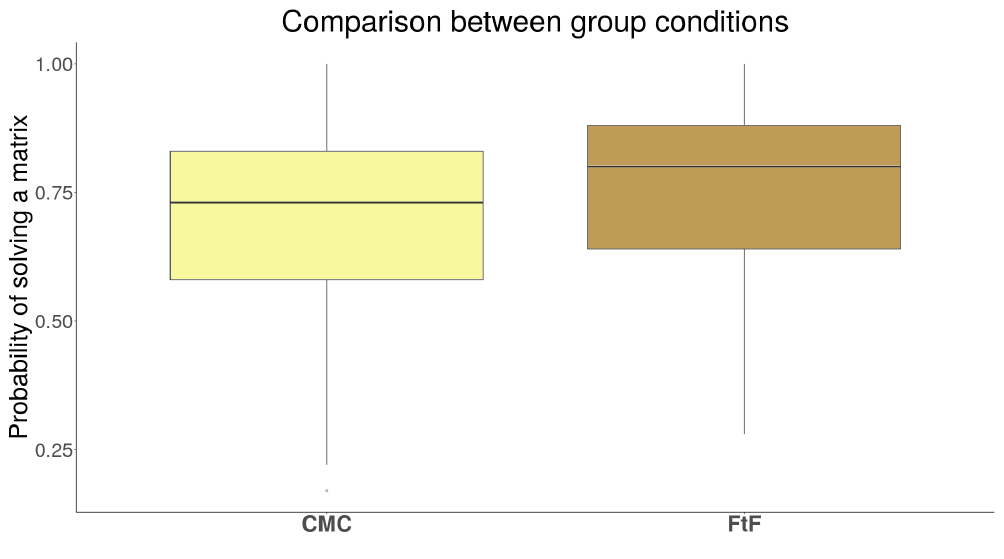
Figure 6. Comparison between performance of groups in CMC and FtF conditions. A box-plot is shown, comparing the performance in RAPM of the groups involved in computer-mediated-communication (CMC) and groups involved in face-to-face condition (FtF). The horizontal lines in the box indicates the median values, respectively Med = 0.733 for CMC and Med = 0.8 for